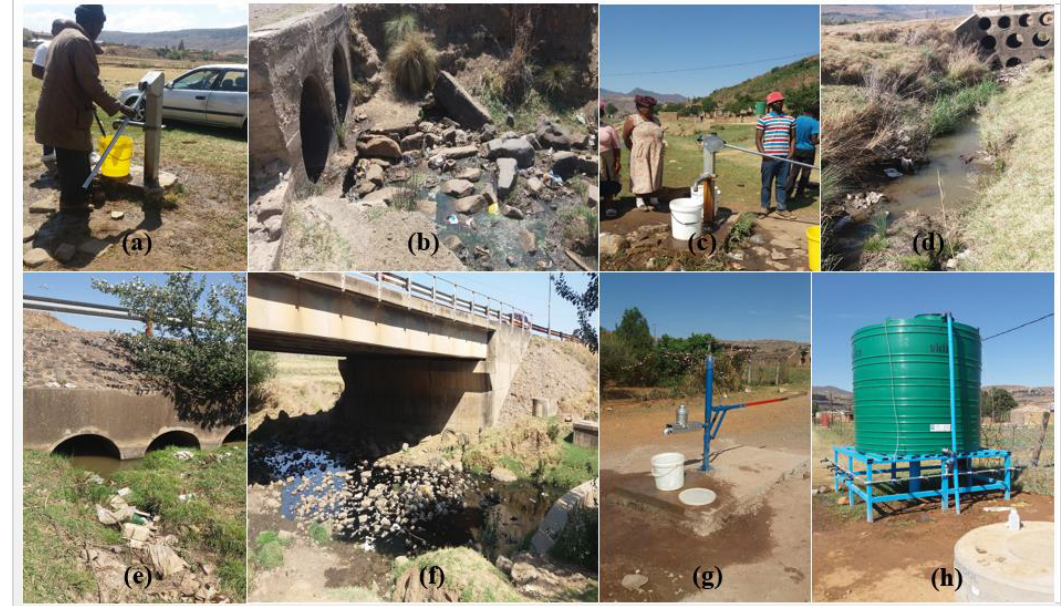
Figure 3. ( a,c,g,h ) Borehole drinking water sources and ( b,d–f ) river Figure 3. (a, c, g, h) Borehole drinking water sources and (b, d, e, f) river sources.